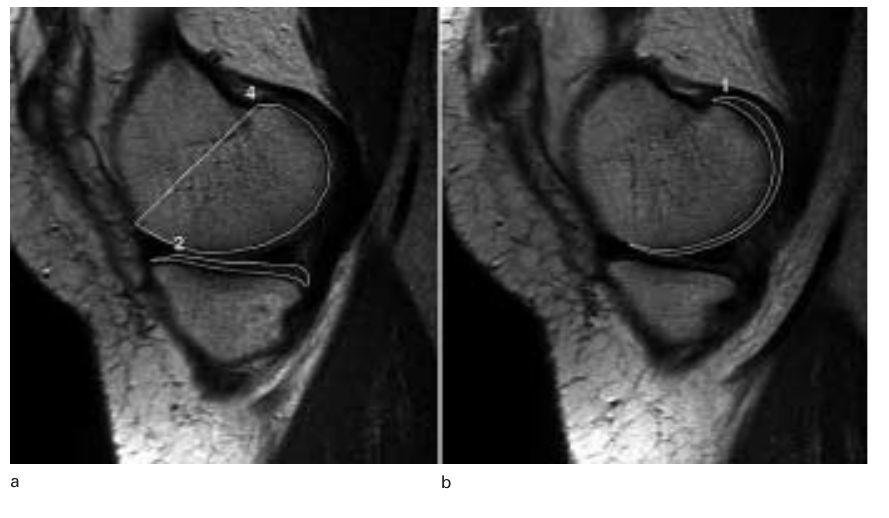
a. Single fast spin- echo proton density- weighted sagittal image of a study sub- ject’s knee with a typ- ical outline of the bone contour and tib- ial cartilage used in the calculation of the bone volume and tib- ial cartilage volume,